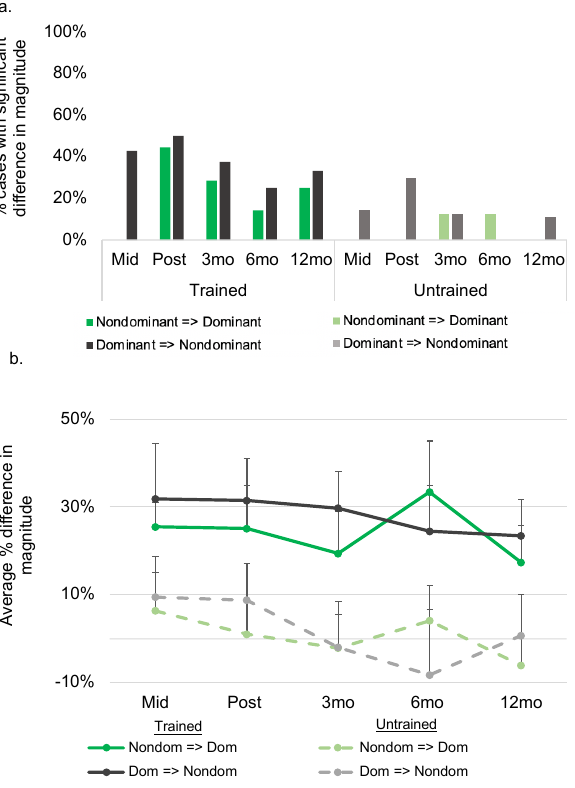
Figure 5. Cross-linguistic transfer for cognates versus noncognates at each time point relative to pre-treatment. ( a ). Depicts the percentage of cases demonstrating a significant difference in the magnitude of transfer between cognates and noncognates at each time point relative to pre-treatment. ( b ). Depicts the average difference in the magnitude of change between cognates and noncognates at each time point relative to pre-treatment. Performance on trained items represents translation effects. Performance on untrained items represents generalization effects. At mid-treatment, seven of nine participants had received treatment in their dominant language and two of three who had received treatment in their nondominant language had sufficient data for these contrasts; the figure shows performance for these subsets at mid-tx for trained and untrained items. See Supplemental Materials for data at the single-subject level. Mid = mid-treatment; mo =